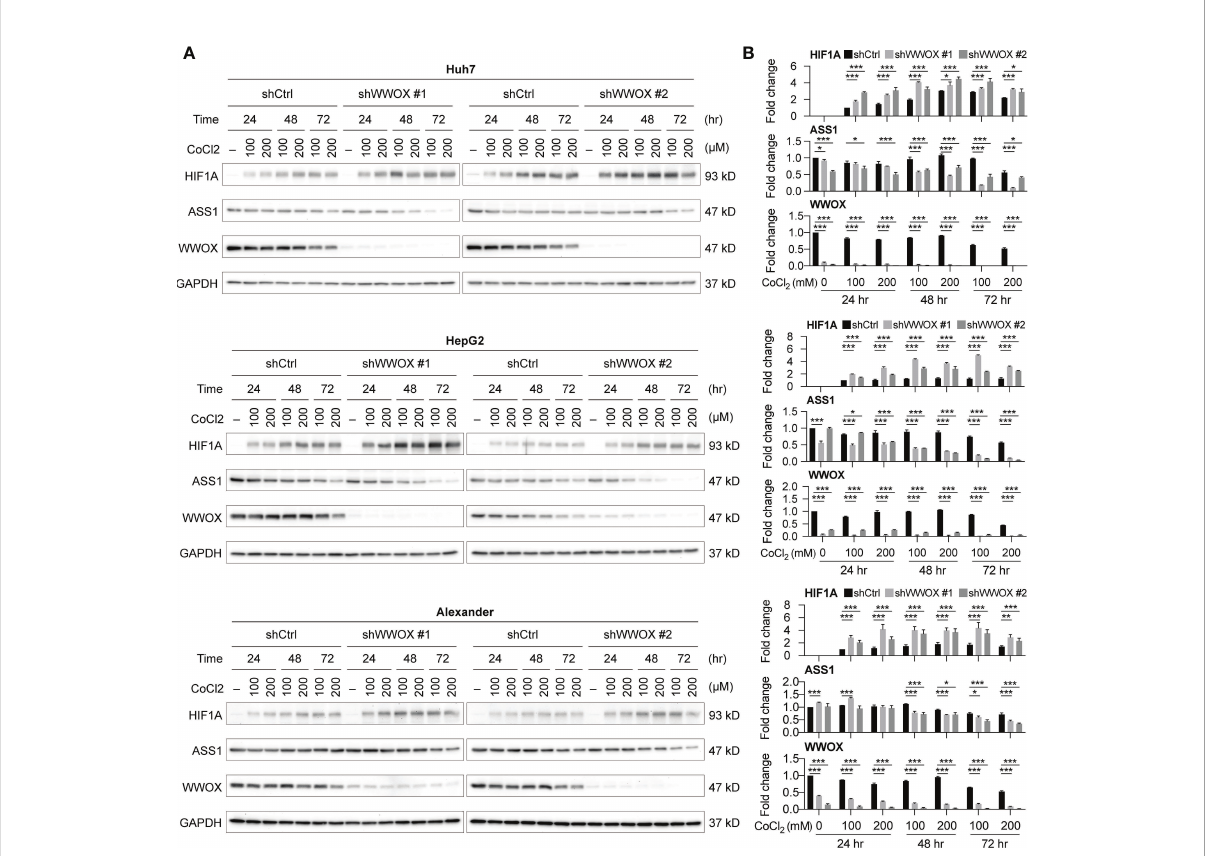
FIGURE 7 WWOX modulates HIF1A expression under hypoxia in HCC. (A) Western blot analysis of HIF1A, WWOX, and ASS1 expression in samples from HCC cells with the indicated treatments. Their quantitative results are summarized in (B) . P values were obtained by two-tailed paired student t - test, and < 0.05 was considered signi fi cant. *P < 0.05; **P < 0.01; ***P <